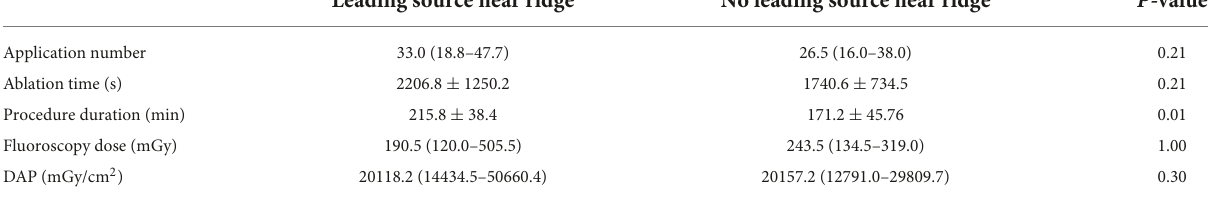
TABLE 2 Procedural data.